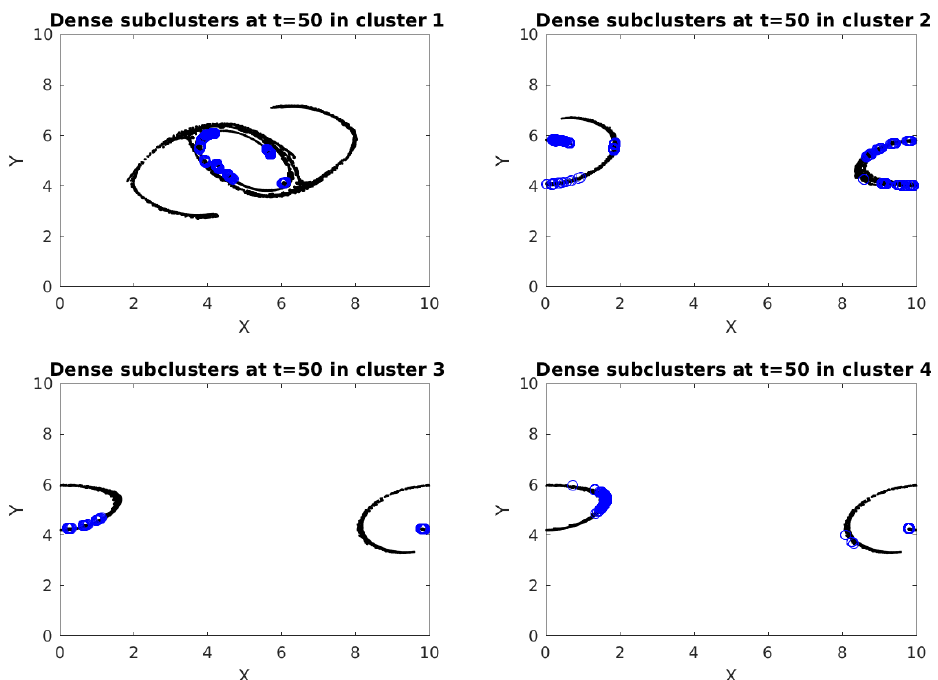
Figure 5. Top four (1 being the largest) cumulative clusters (black) with their dense subclusters (blue) found at time 50. Spatially separated blue regions are distinct subclusters, with each of them having a minimum degree of 5 within themselves and hence being called